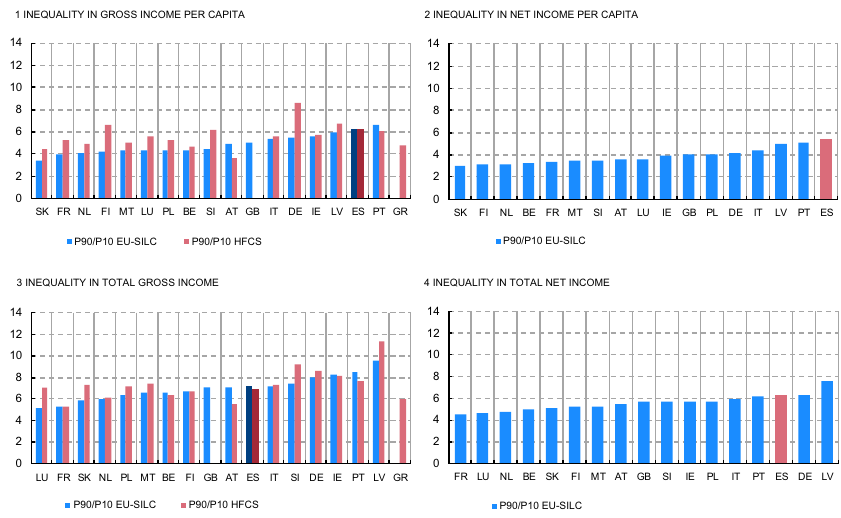
Fig. 5 International comparison of inequality indicators. Household income (2014). Sources : Eurostat (European Union Statistics on Income and Living Conditions—EU-SILC—) and European Central Bank (European Household Finance and Consumption